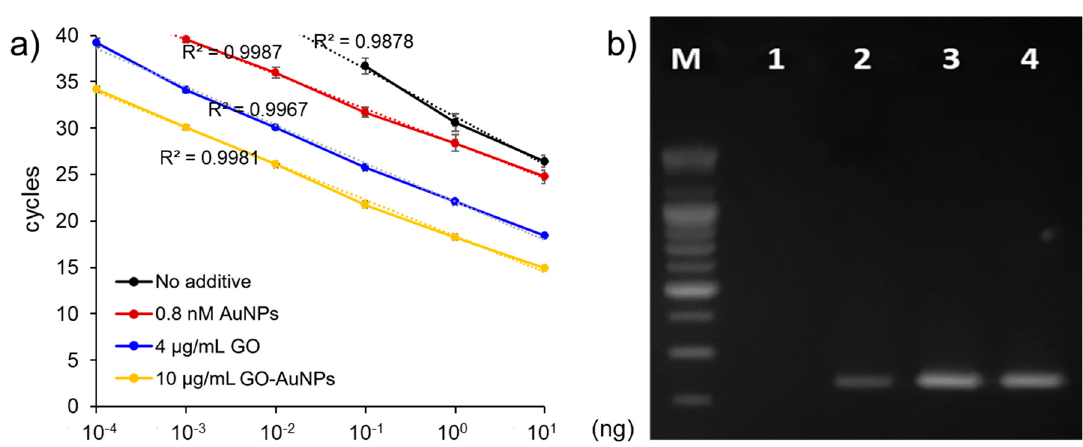
Figure 4. Comparison of additive efficiency in nano-PCR. ( a ) Standard curve of cycle values (Cq). ( b ) Size of nano-PCR product determined by agarose gel electrophoresis. Lane 1, no additives; Lanes 2–4, 0.8 nM AuNPs, 4 µg/mL GO, 10 µg/mL GO-AuNPs, respectively.